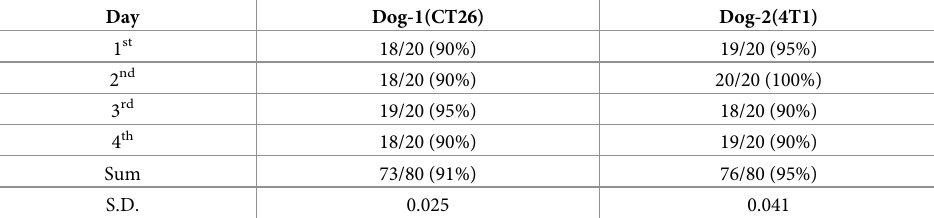
Table 2. Detection accuracy for the unfamiliar cancer samples.